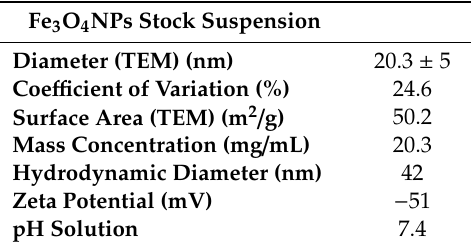
Table 1. Physico-chemical properties of Fe 3 O 4 NPs stock